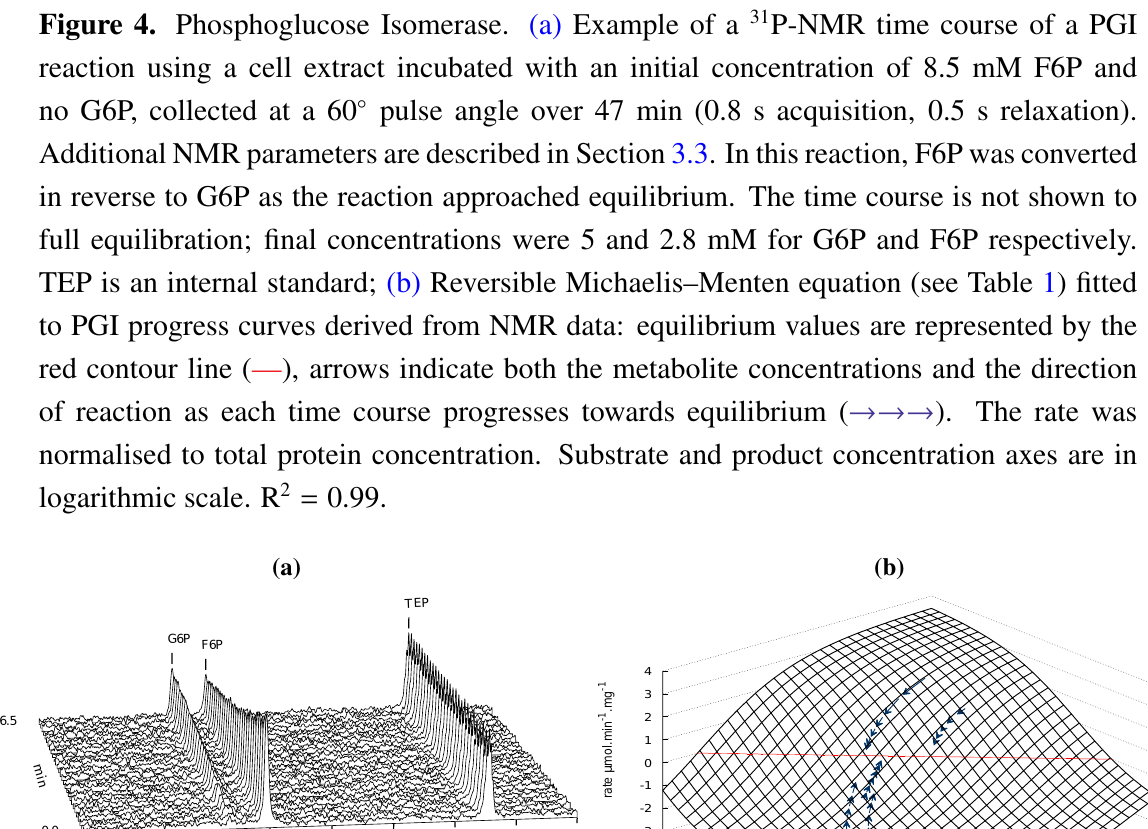
Fitted half-saturation constants for G6P (0.550 ± 0.236 mM) and F6P (0.152 ± 0.017 mM), maximal forward rate (3.551 ± 0.050 µ mol . min − 1 . mg − 1 ) and the equilibrium constant (0.286 ± 8 × 10 − 6 ) are comparable with literature values: G6P micro-aerobic 4.66 µ mol . min − 1 . mg − 1 [38], K most likely due to the sparsity of data at and below the half-saturating concentration of G6P (Figure